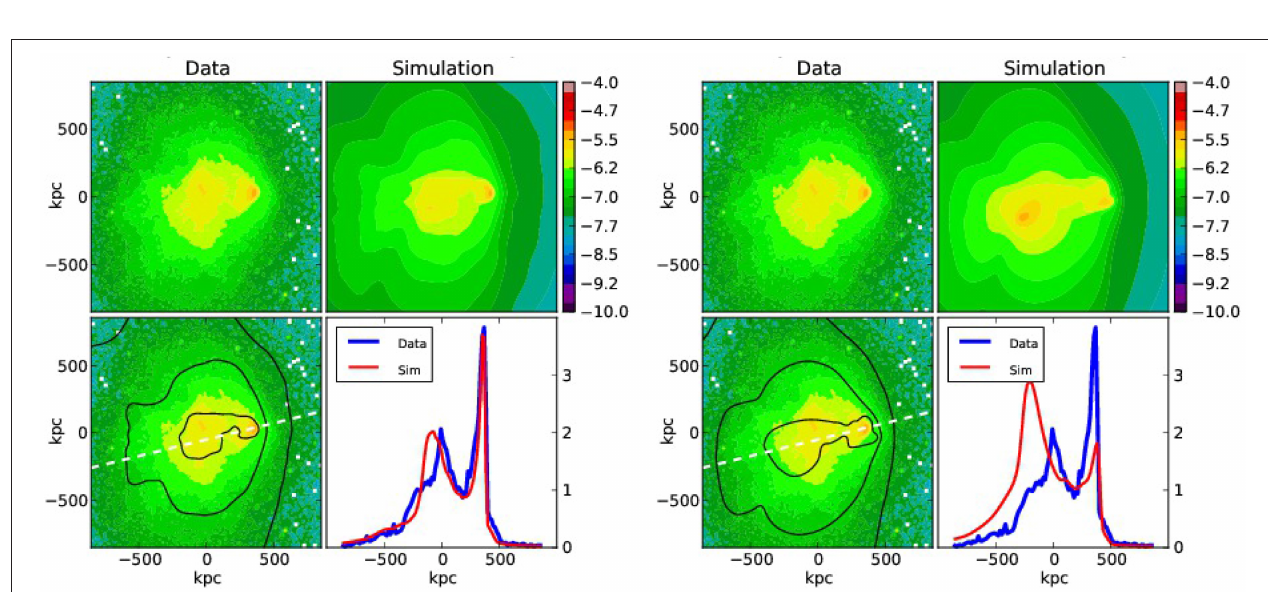
FIGURE 6 | Data and the results based on the best fit simulations for the Bullet cluster. Left Panel: The mass distribution reconstructed from weak lensing data and from simulations are shown in the first row, the data with contours from the best fit simulation shown in left panel in the second row. The right panel in the second row displays the mass distribution from the data and from simulations along the cut shown as dashed line in the left panel. Right Panel: The X-ray surface brightness distribution in the range of 0.5–2keV is shown in the left panel in the first row. The other three panels show the data and the simulations along three cuts marked as white, yellow, and black dashed lines (from Lage and Farrar, 2014).